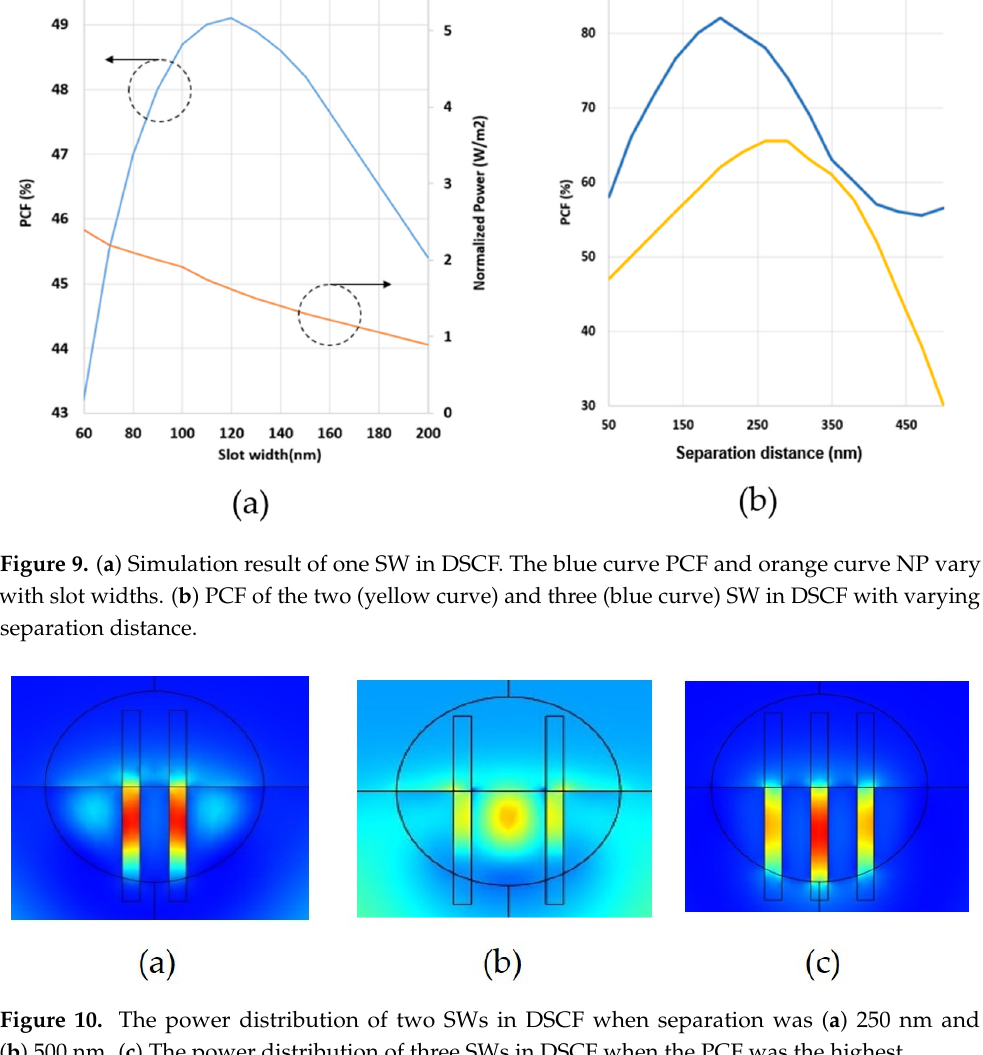
Figure 10. The power distribution of two SWs in DSCF when separation was ( a ) 250 nm and ( b ) 500 nm. ( c ) The power distribution of three SWs in DSCF when the PCF was the